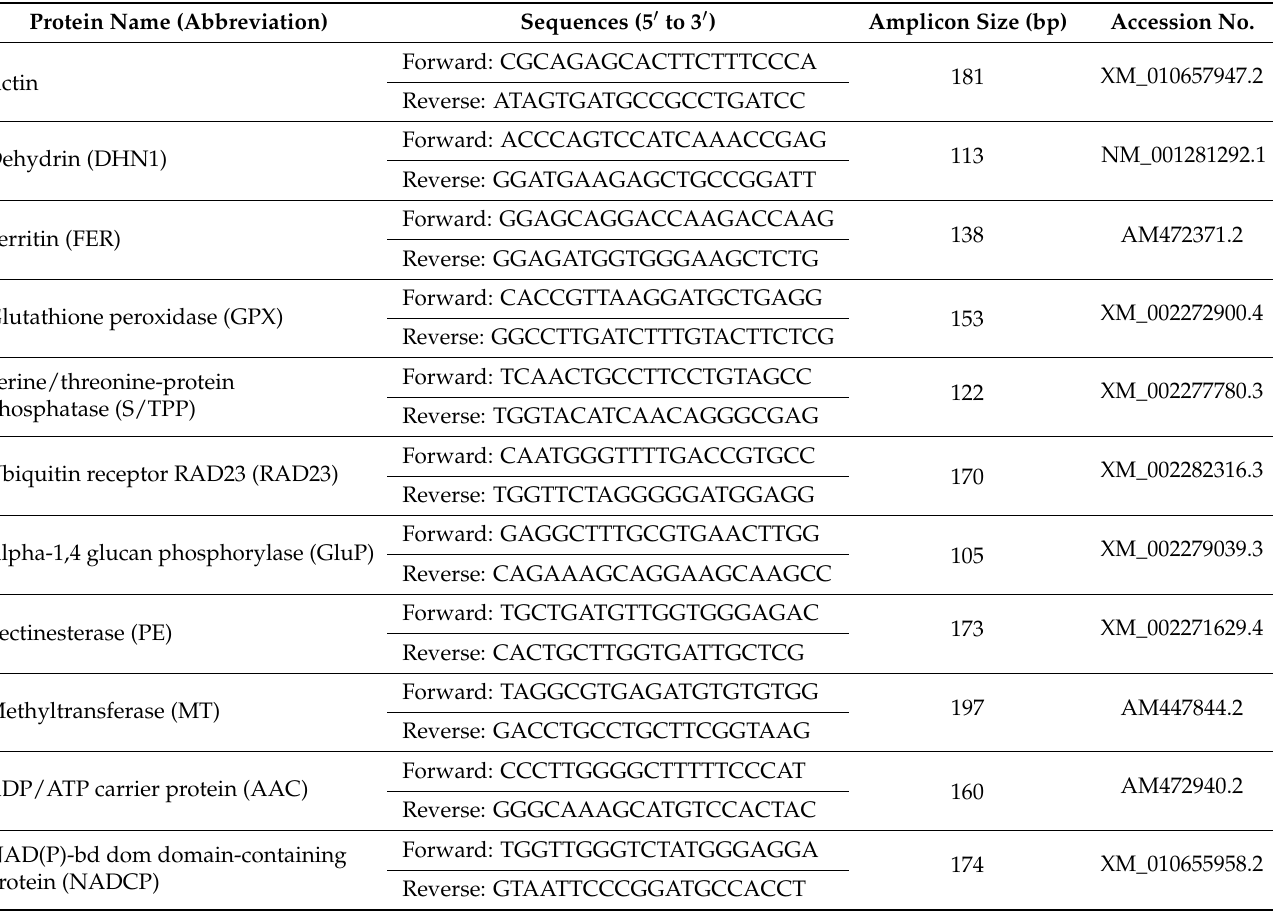
Table 2. Sequences of primers used in qRT-PCR